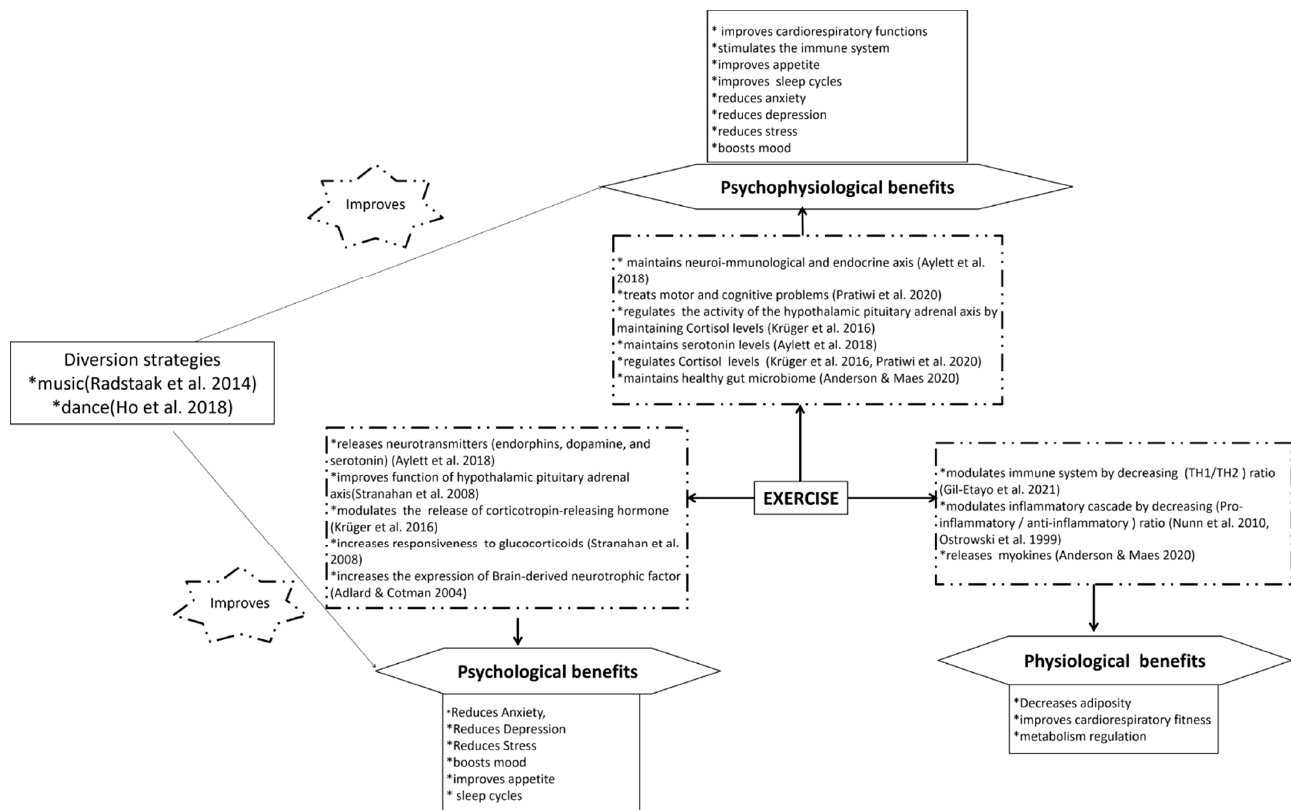
Figure 1. Summary figure showing the preventive role of exercise on physiological, psychological and psychophysiological effects of COVID-19.